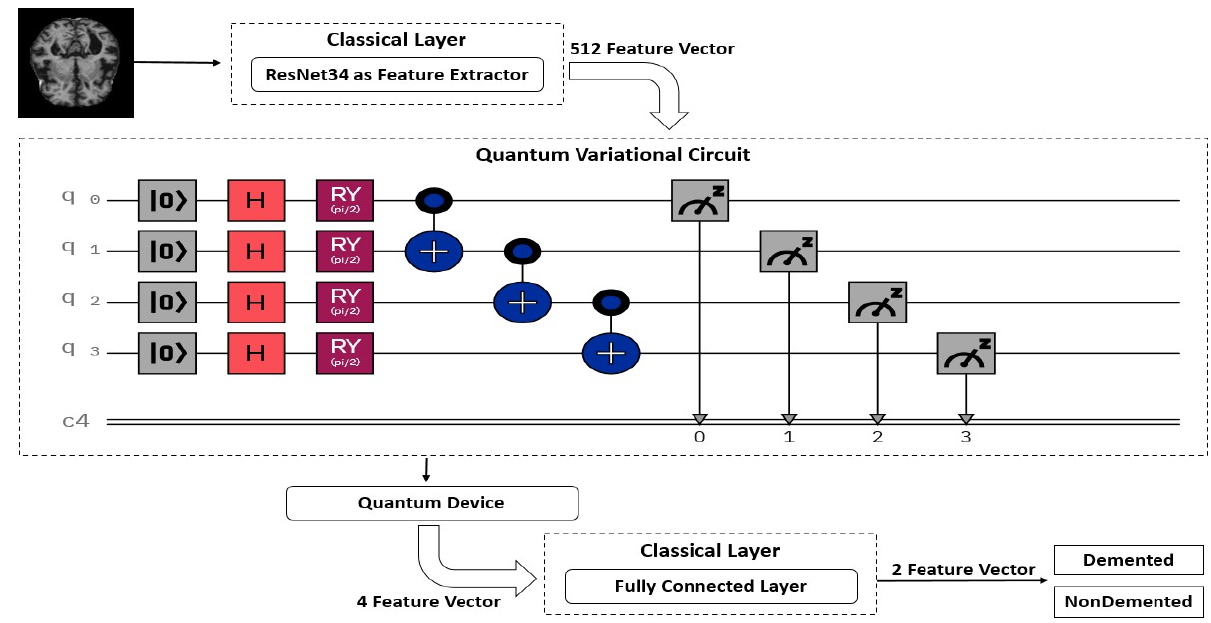
Figure 3. Demonstration of data processing using quantum–classical transfer learning.